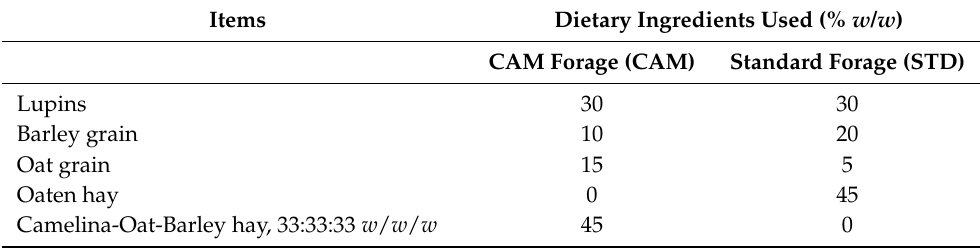
Camelina-Oat-Barley hay, 33:33:33 w / w /